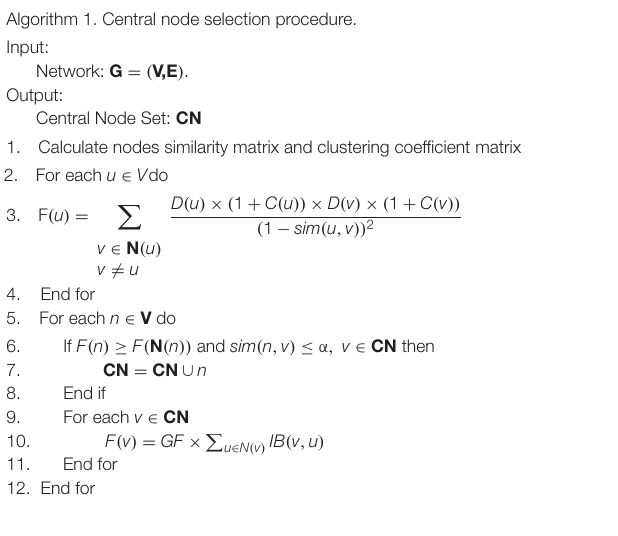
Algorithm 1. Central node selection